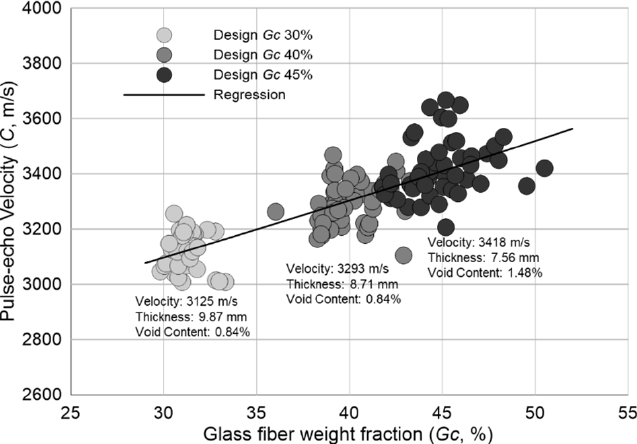
Figure 3. Statistical results for pulse-echo velocity as a function of